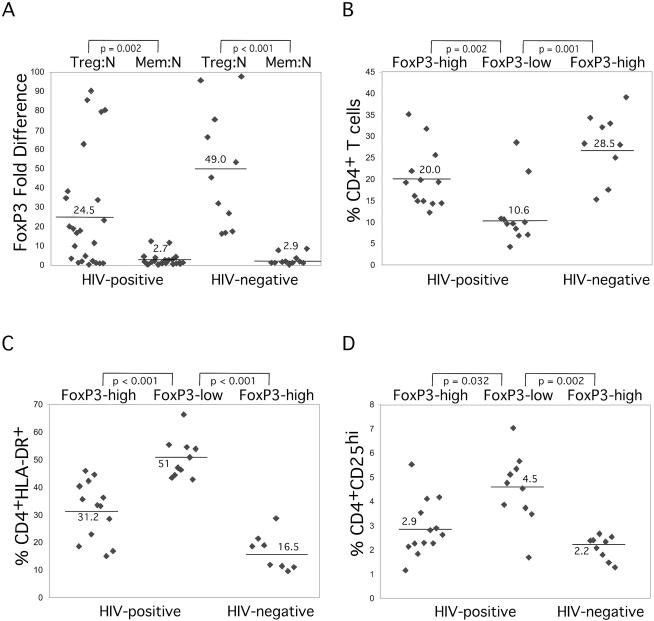
FoxP3 Expression in Purified CD4+CD25hi (Treg), Naïve, and Memory T-cells from HIV-Infected and Healthy Individuals(A) RNA was isolated from sorted Treg, naïve, and memory T-cells from HIV-positive (n = 24) and HIV-negative (n = 11) subjects, followed by cDNA synthesis. FoxP3 expression was quantified by TaqMan real-time PCR. The FoxP3-fold difference expression was calculated for CD4+CD25hi (Treg) versus naïve (N), and memory (Mem) versus naïve (N) T-cells. Treg cells sorted from HIV-positive subjects were further subdivided into two groups based on FoxP3 expression of Treg compared to naïve T-cells (FoxP3-high, n = 13, FoxP3 difference >10-fold; FoxP3-low, n = 11, FoxP3 difference <10-fold; HIV-negative, n = 9). These groups were stained with anti-CD3, anti-CD4, anti-CD45RO, anti-CD25, and anti-HLA-DR and analyzed by flow cytometry for (B) CD4+ T-cell percentage, (C) activated T-cell percentage (CD4+HLA-DR+), and (D) CD4+CD25hi percentage. Horizontal lines identify means. Statistical significance between groups was determined by Mann–Whitney U test and shown on top of each figure.